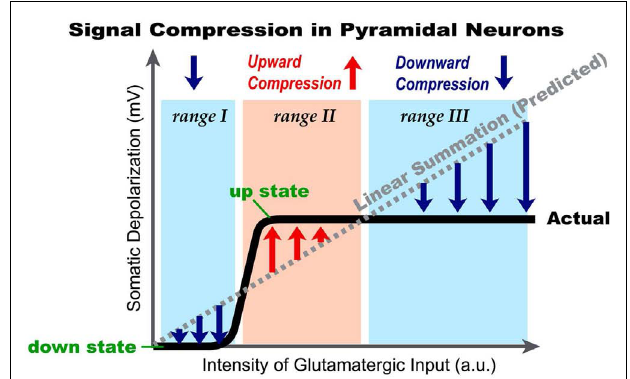
FIGURE 12 | Cellular bases of signal compression in the basilar dendritic tree of cortical pyramidal neurons. Schematic representation of data obtained by summation of glutamatergic inputs in the basilar dendritic tree.Thick black line ( Actual ) represents a sigmoidal shape of somatic depolarization obtained experimentally by gradually increasing the intensity of glutamatergic stimulation delivered on one basal dendrite or by summation of inputs from two basal branches.The dashed gray line represents an expected depolarization in the cell body, based on the arithmetic (linear) summation of plateau potentials occurring in one or two basal dendrites simultaneously. Pink rectangle marks the range of glutamatergic input intensities ( range II ), in which cellular (dendritic) mechanisms boost the amplitude of the somatic depolarization. Blue rectangle marks the range of glutamatergic input intensities ( range III ), in which cellular mechanisms (dendritic and somatic) suppress the amount of somatic depolarization. As a result of active boosting (red arrows) or active suppression (blue arrows) the neuronal output (somatic depolarization) is compressed in a narrow range of amplitudes, marked by “ up state